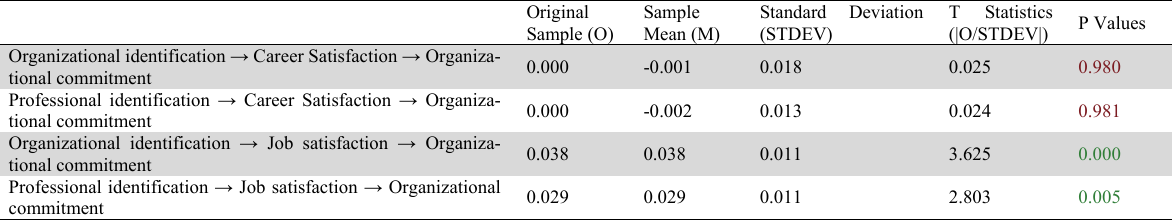
Specific Indirect